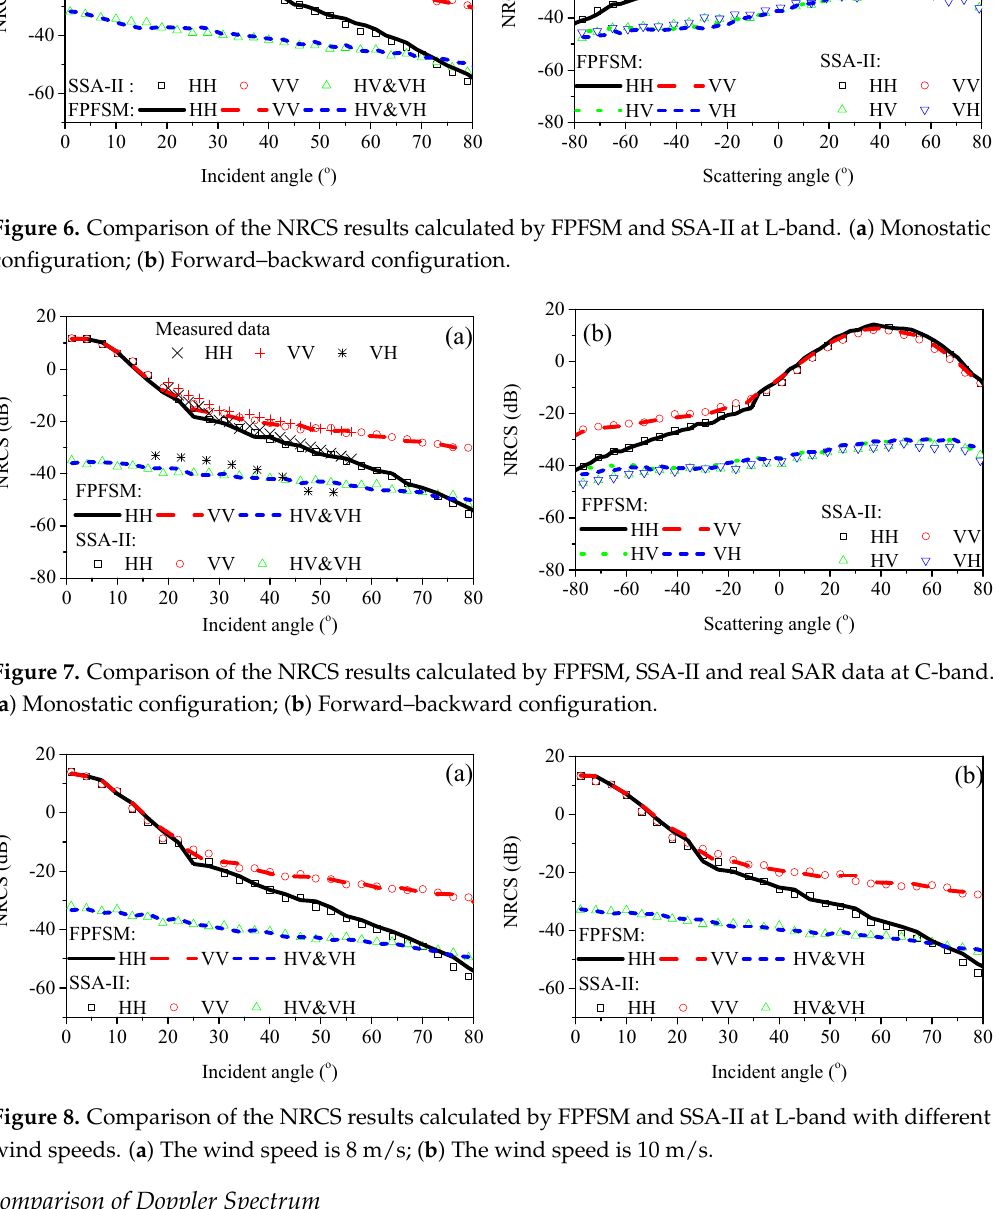
Figure 8. Comparison of the NRCS results calculated by FPFSM and SSA-II at L-band with different wind speeds. ( a ) The wind speed is 8 m/s; ( b ) The wind speed is 10 m/s.